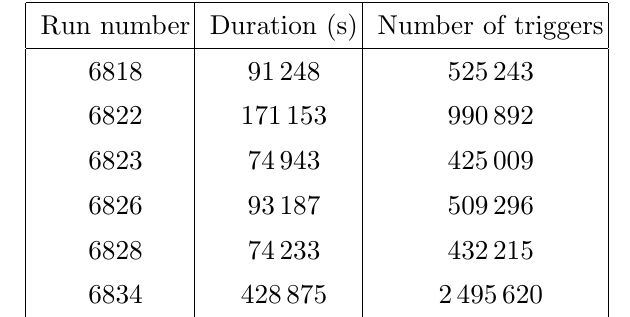
Figure 2 . Example of reconstructed hits (left) and subsequent voxelization (right). This event was produced by a 228 Th calibration source.